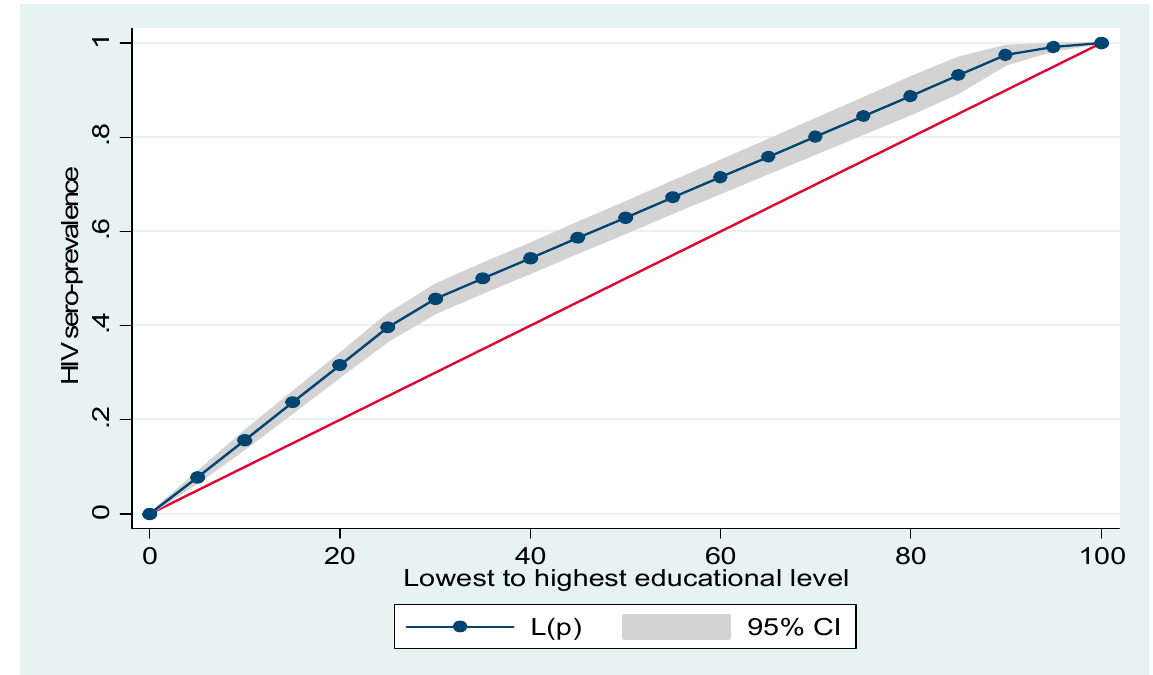
Figure 2. Lorenz curve for HIV prevalence by women’s education.